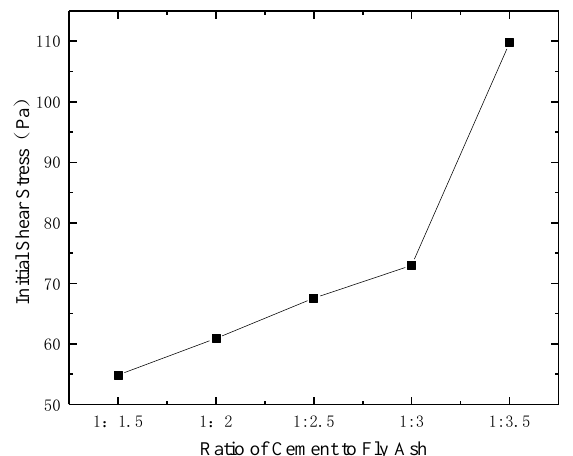
Figure 15. Relation between initial shear stress and different ratios of cement to fly ash.